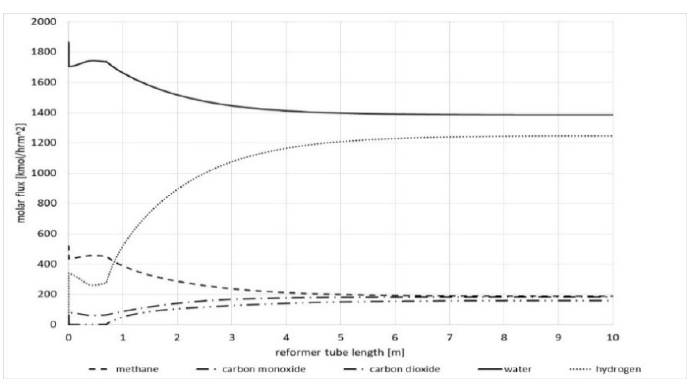
Figure 7. Dependence of heat duty as a function of reactor length.